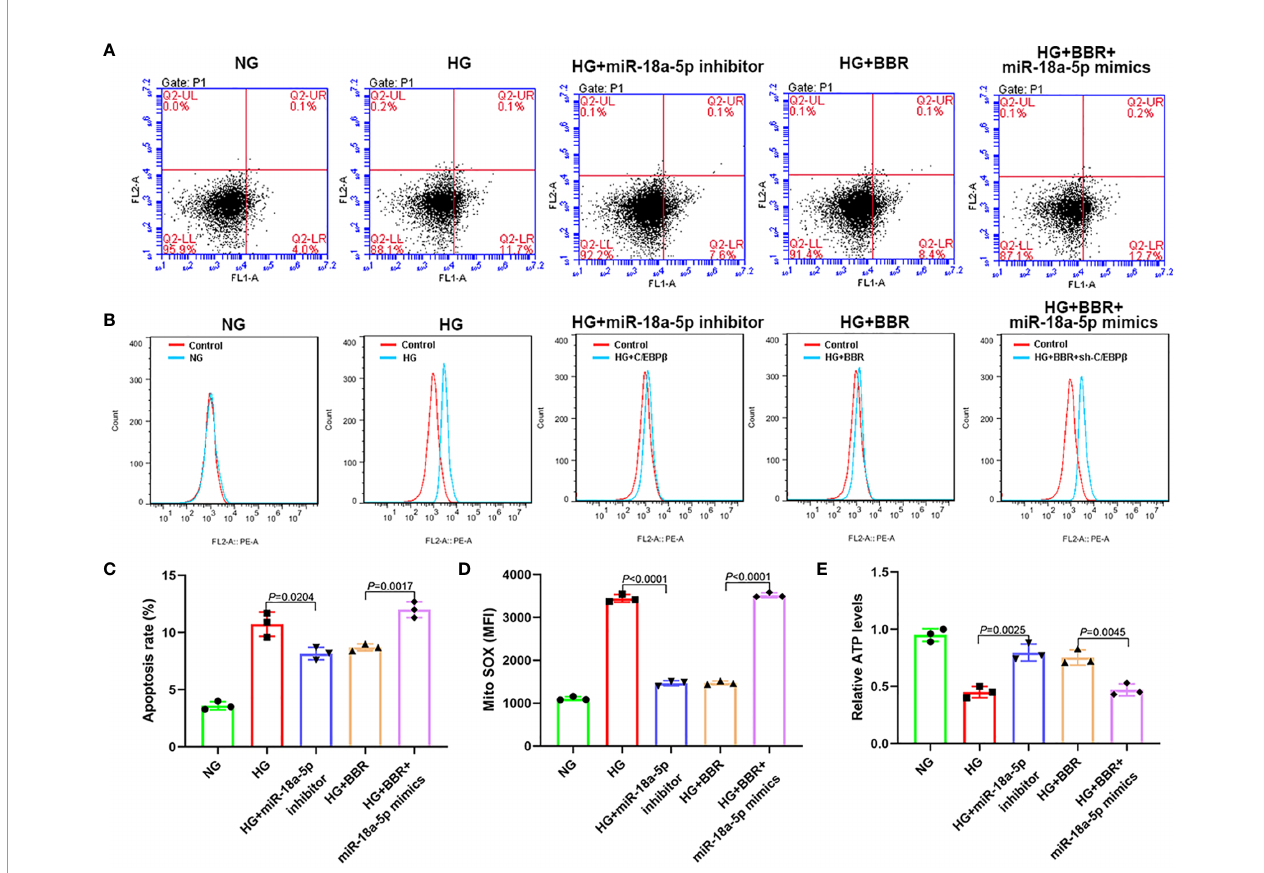
FIGURE 7 | The expression level of miR-18a-5p was related to the mitochondrial ROS levels of HK-2 cells in high glucose environment. (A, C) The apoptosis ratio in different groups. (B, D) Mitochondrial ROS levels in different groups. (E) Relative ATP content in HK-2 cells of different